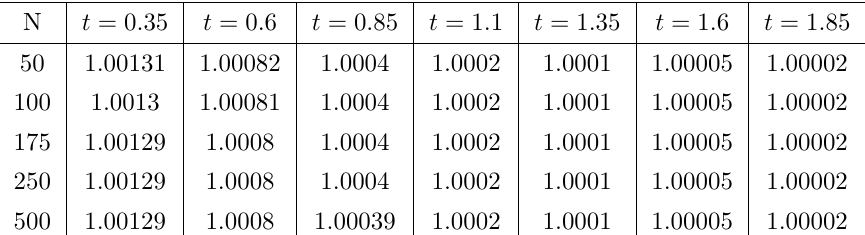
Table 13 . A comparison of the value of the correlation function at various di(cid:11)erent grid sizes. This data was calculated for a transverse separation of l = 0 : 5 in a neutral thermalizing (cid:13)uid (dual to the relaxation towards a Schwarzschild black brane geometry) (cid:26) = 0, B = 0